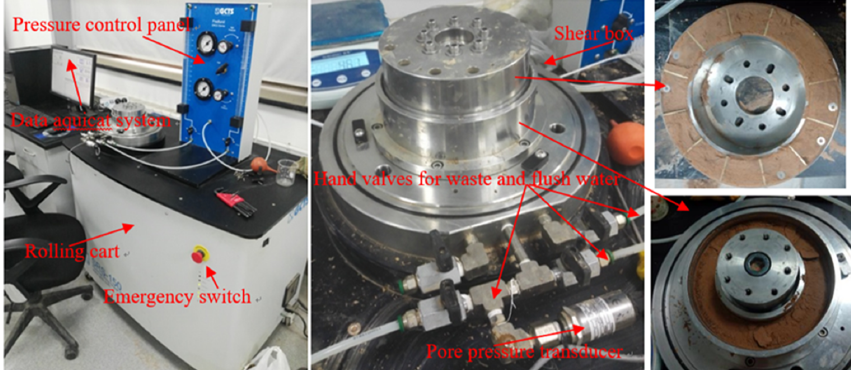
Figure 3. Ring shear apparatus